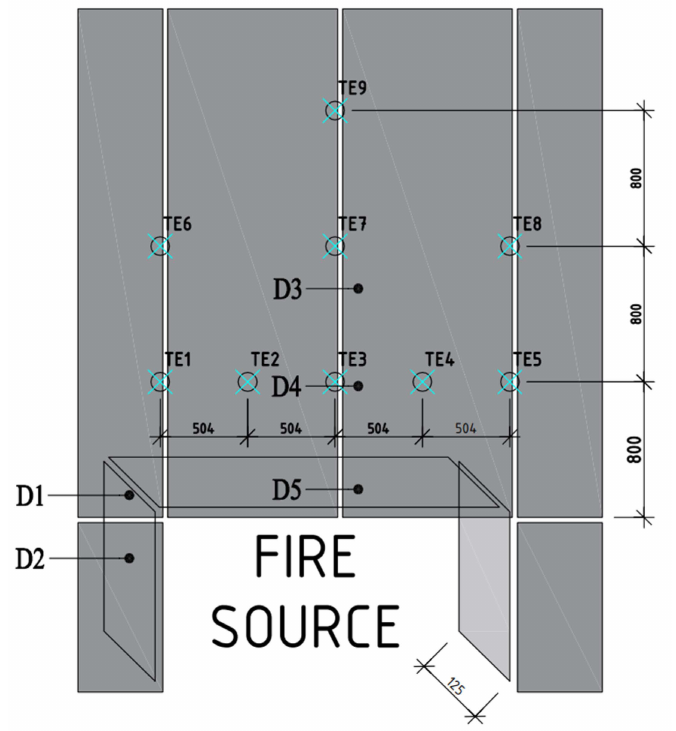
Figure 3. Layout of the exterior cladding panels and thermocouples along with sampling location.